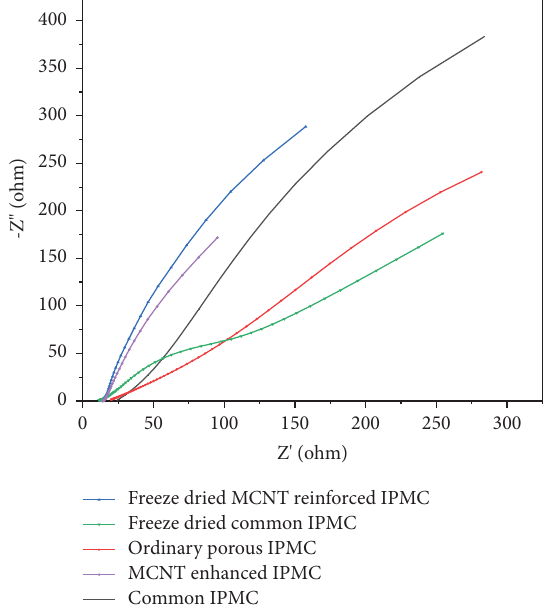
Figure 8: EIS curve.